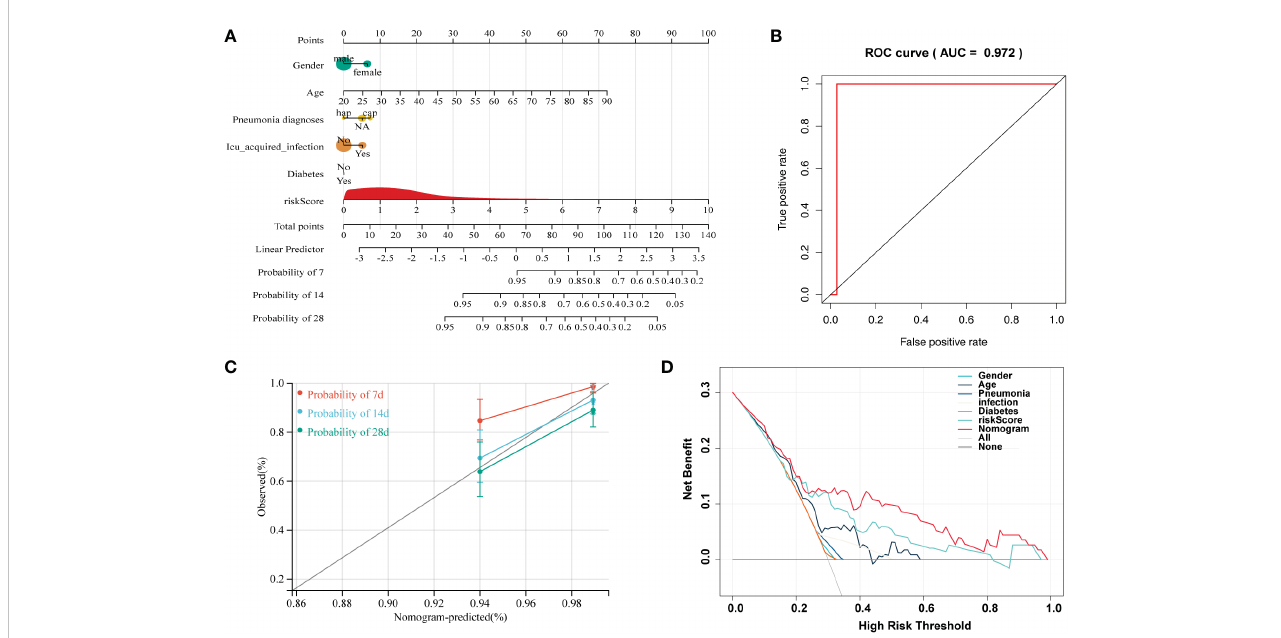
FIGURE 9 A nomogram developed for predicting sepsis mortality. (A) Nomogram for predicting 7-, 14-, and 28- days survival based on the immune gene signature and clinical features. (B) ROC curve for survival prediction of the nomogram. (C) Calibration plot of the nomogram for the prediction of survival. (D) DCA of the nomogram for the prediction of